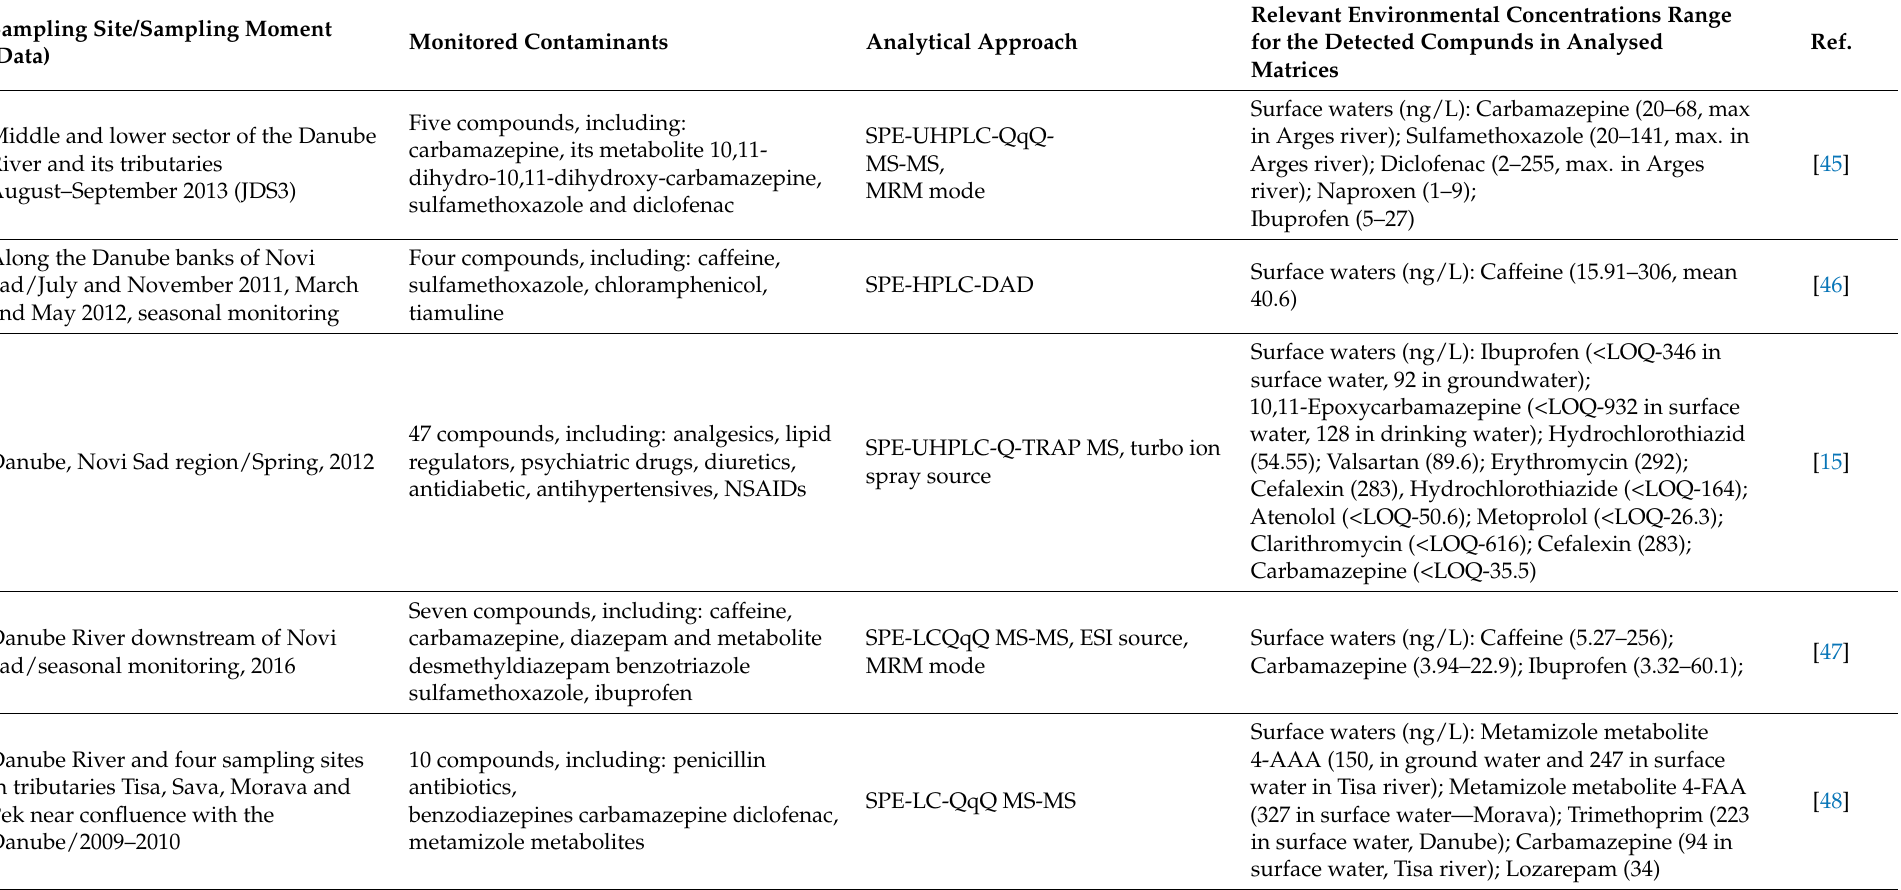
Table 1. Summary of the publication during 2010–2021 on the area of Lower Danube and North-West Black Sea Basins concerning pharmaceuticals